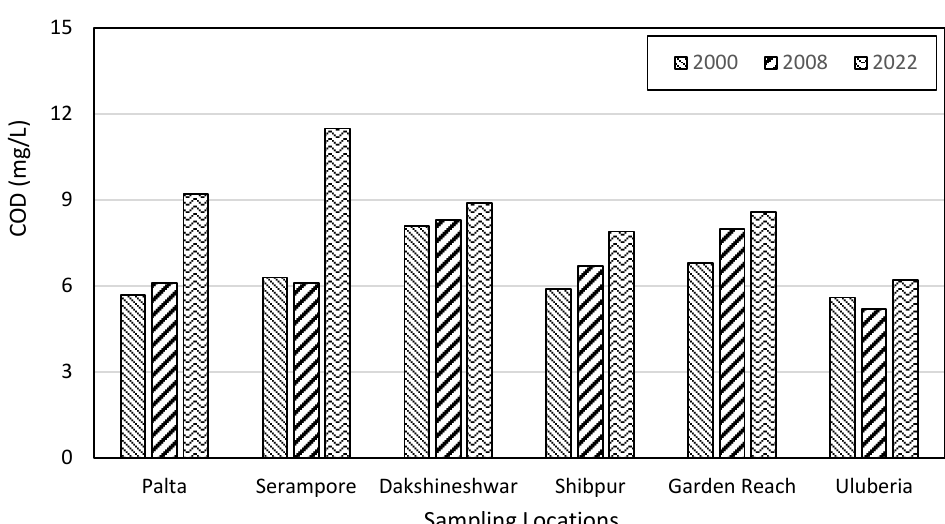
Figure 12. Variation of COD in different locations.